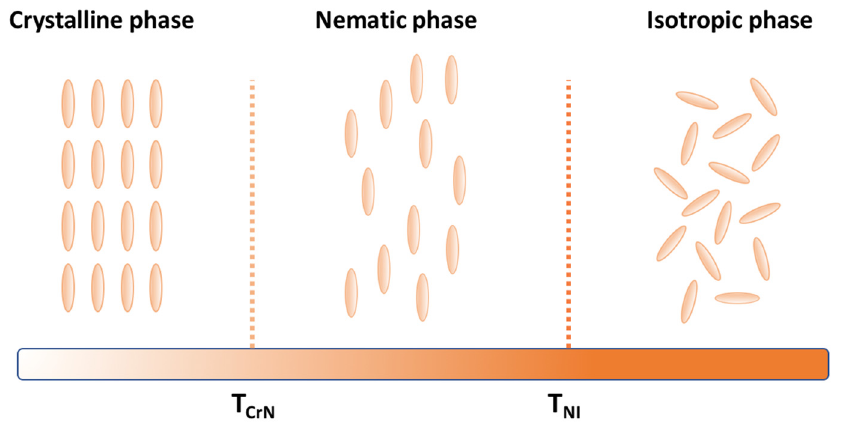
Figure 1. Phase transition behavior for a nematic LC with an increase in temperature.